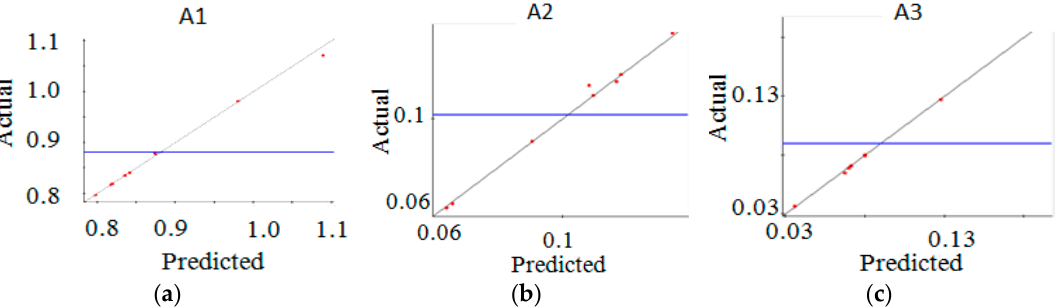
Figure 11. Comparison between calculated results and approximate model with misalignment fault.